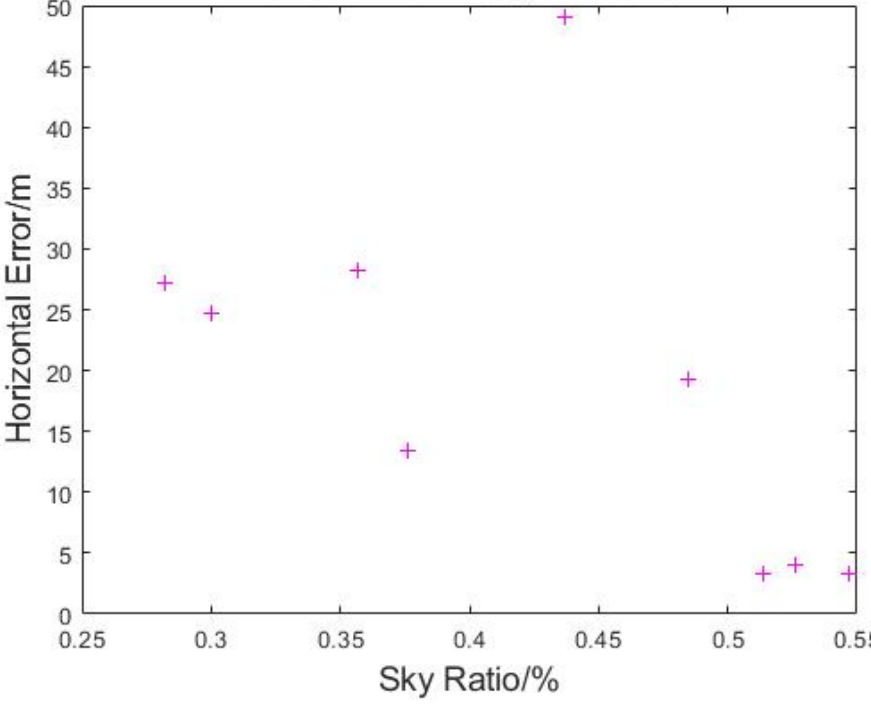
Figure 18. Plot of Measured Horizontal Error vs. Sky Ratio at N3.1.